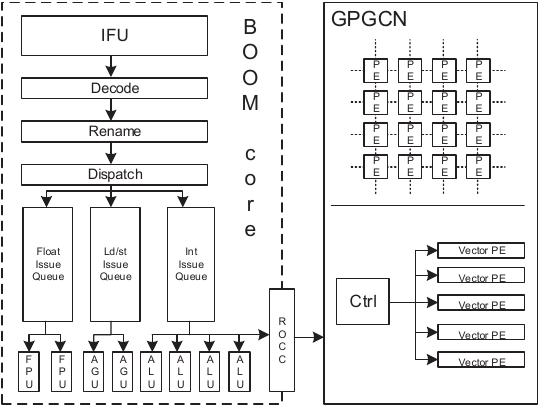
Figure 22. The overall architecture of GPGCN with boom cpu.